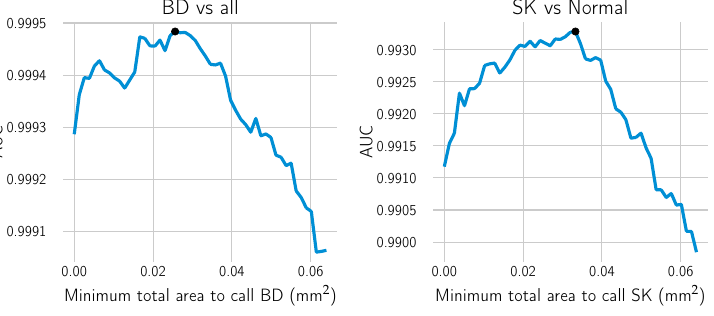
Figure 7. The optimal minimal area to call “BD vs. all” or “SK vs. Normal” was computed using a line search. The AUC was computed for each candidate’s minimal area on the combined training and validation datasets. For each call, the smallest area yielding the highest AUC was selected (black dot).